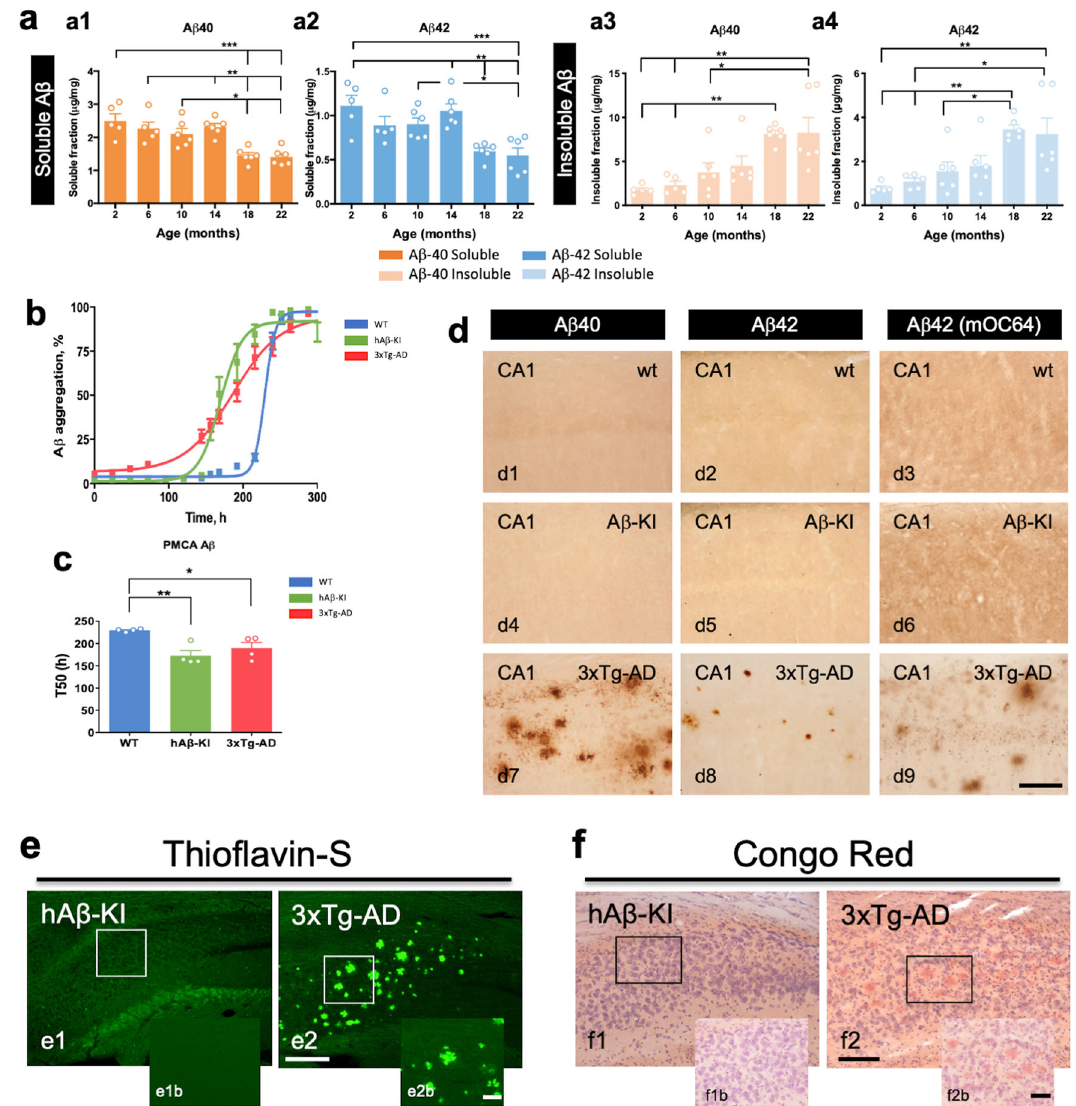
Fig. 2 Changes in A β as a function of age in hA β -KI mice. a A β 40 (orange) and A β 42 (blue) quantity in hA β -KI homozygous mice was determined using the MSD V-PLEX Plus A β Peptide Panel 1 (6E10) Kit ( n = 5 in 2 mo and 6 mo and n = 6 in 10 mo, 14 mo, 18 mo and 22 mo). The ELISA analysis shows that hA β -KI mice produce high soluble A β levels, including A β 40 (One-way ANOVA, F 5,28 = 10.01, Tukey ’ s post hoc test, * p < 0.05, ** p < 0.01 and *** p < 0.001) and A β 42 (One-way ANOVA, F 5,28 = 8.057, Tukey ’ s post hoc test, * p < 0.05, ** p < 0.01 and *** p < 0.001) compared to old hA β -KI mice (a1 and a2). Opposite effect is observed in insoluble A β levels in older hA β -KI mice compared to younger hA β -KI mice, including in A β 40 (One-way ANOVA, F 5,28 = 7.21, Tukey ’ s post hoc test, * p < 0.05 and ** p < 0.01) and A β 42 (One-way ANOVA, F 5,28 = 6.543, Tukey ’ s post hoc test, * p < 0.05 and ** p < 0.01) (a3-a4). b A β -PMCA shows accelerated in vitro aggregation using hA β -KI (green) and 3xTg-AD (red) brain homogenate to seed monomeric A β compared to WT (blue) controls ( n = 4/genotype). c Shorter time to reach 50% of total aggregation, measured by thio fl avin-T emission levels ( n = 4/genotype) (One-way ANOVA, F 2,11 = 9.083; Tukey ’ s post hoc test, * p < 0.05 and ** p < 0.01). d Immunohistochemistry performed with A β 40 and A β 42 antibodies showed no sign of aggregates (plaques) for A β isoforms in hA β -KI mice at 22-month of age (d4 – d6). As a positive control, 3xTg-AD mice were used with signi fi cant A β 40 and A β 42 aggregates present at 22-month of age (d7 – d9). WT mice showed no staining for both A β isoforms (d1 – d3). 22-month-old hA β -KI mice and 3xTg-AD mice were stained with thio fl avin-S (Thio-S) ( e ) or Congo Red ( f ) stain. No fi brillar aggregated stained with Thio-S or Congo red is observed in hA β -KI (e1 and f1). As a positive control, 3xTg-AD mice were used with fi brillary extracellular aggregates positive for Thio-S and Congo Red present in the hippocampus (e2 and f2). Data are presented as mean values ± SEM. Scale bar: 200 μ m (e1, e2, f1 and f2), 100 μ m (d1 – d9) and 50 μ m (e1b, e2b, f1b and synaptic physiology are impacted in homozygous hA β -KI mice, we examined the effects on long-term potentiation (LTP), a form of synaptic plasticity, as well as on baseline synaptic transmission. Theta-burst stimulation-induced LTP revealed de fi cits in the fi eld excitatory postsynaptic potentials (fEPSPs) 50 – 60 min post- induction in slices from male and female homozygous hA β -KI mice versus slices from WT mice at 18 months of age (Fig. 5c). showed a signi fi cant reduction at presynaptic level (recognized